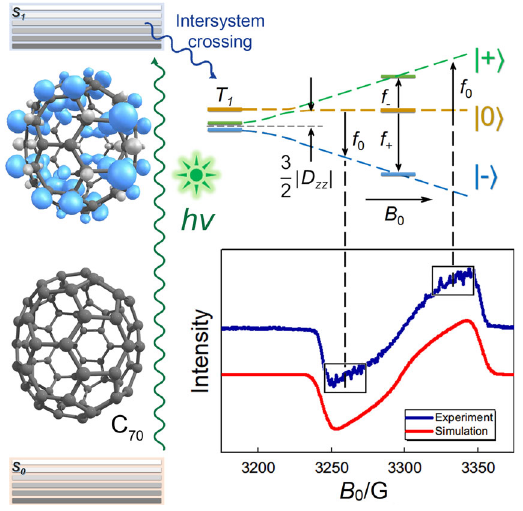
Fig. 1 Energy levels and EDFS spectrum. Energy levels involved in the experiments with the molecular structure and calculated spin density of the photoexcited triplet of C 70 . The inset is the measured and simulated EDFS spectrum. The vertical dashed lines mark the fi elds in which the measured (see next section) portion of molecules signal. Boxes mark the range in which the molecules are affected by the preparation, transformation and reversion